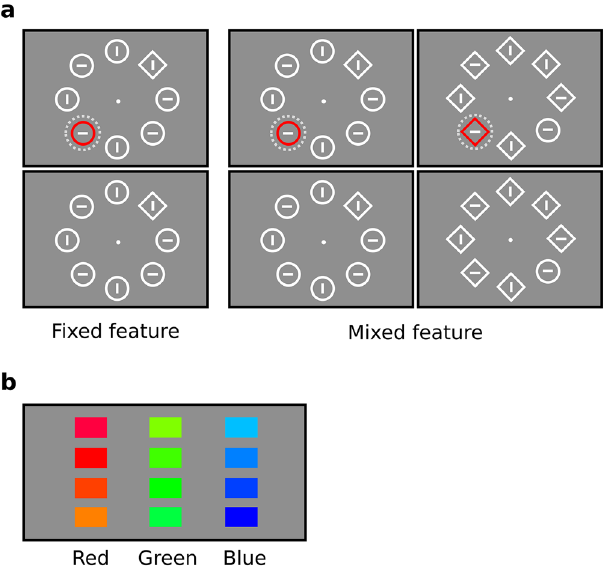
Figure 1. Stimuli and task. ( a ) Examples of the visual search displays. Participants search for a fixed-feature target (diamond; left panel) or a mixed-feature target (diamond or circle; right panels) and report the orientation of the line embedded in it. In 2/3 of the distractor-present trials (top row) the colour distractor was presented at the high-probability location. The high-probability location was chosen randomly for each participant (illustrated by the dotted line, not visible in the experiment). In 50% of trials, no additional colour distractor was presented (bottom row). ( b ) Colour-array. Two out of three colours (red, green, blue) were chosen randomly for each participant. Participants were asked to select a colour hue for each of these two colours. The chosen hues became the colours of the colour